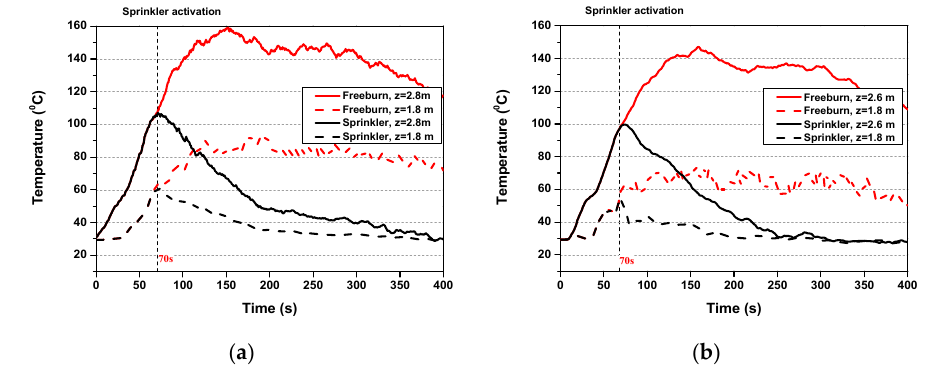
Figure 10. Variation in the temperature at ( a ) location A; ( b ) location B.